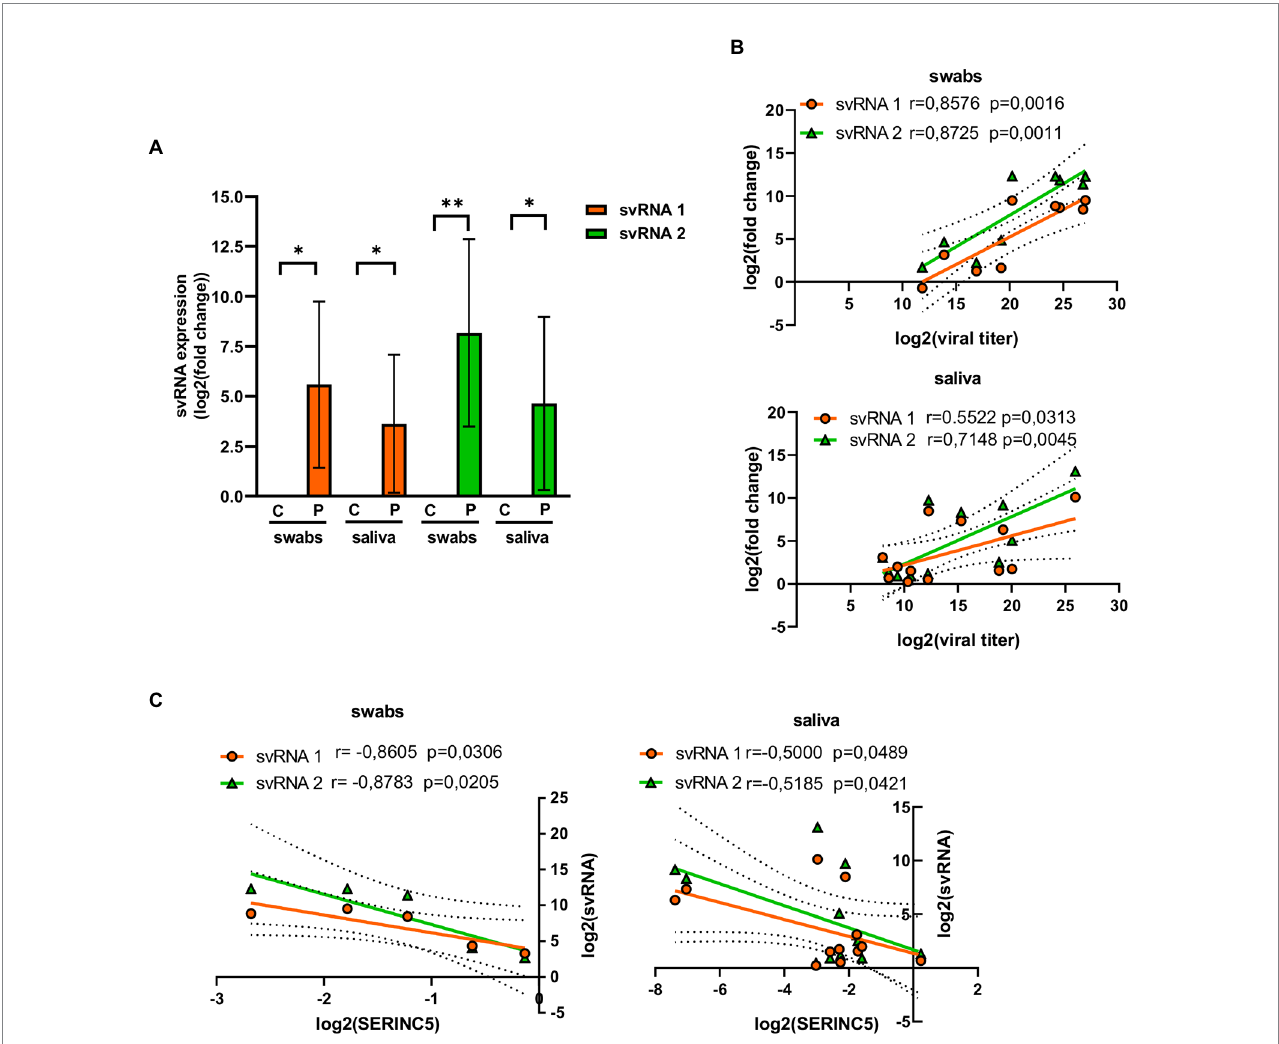
FIGURE 3 Analysis of the levels of svRNA 1 and 2 in nasopharyngeal and saliva samples of COVID-19 patients. (A) RT-qPCR analysis of the expression of svRNA 1 and svRNA 2 in nasopharyngeal (swabs) and saliva samples from COVID-19 patients (P) with respect to control samples (C). The control value represents the mean of all control samples. The ΔΔ Ct method was used for relative quantification with U6 snRNA as an endogenous control. Data are represented as log2 fold change with respect to control samples. (B) Correlation analysis between log2 fold changes obtained for svRNA 1 or svRNA 2 and log 2 viral titers in swabs (top) and saliva (bottom) samples. (C) Correlation analysis of log2 fold changes obtained for svRNA 1 or svRNA 2 and SERINC5 mRNA in swabs (left) and saliva (right) samples. Differences from control values were found to be statistically significant at * p < 0.05, ** p < 0.01, and *** p <